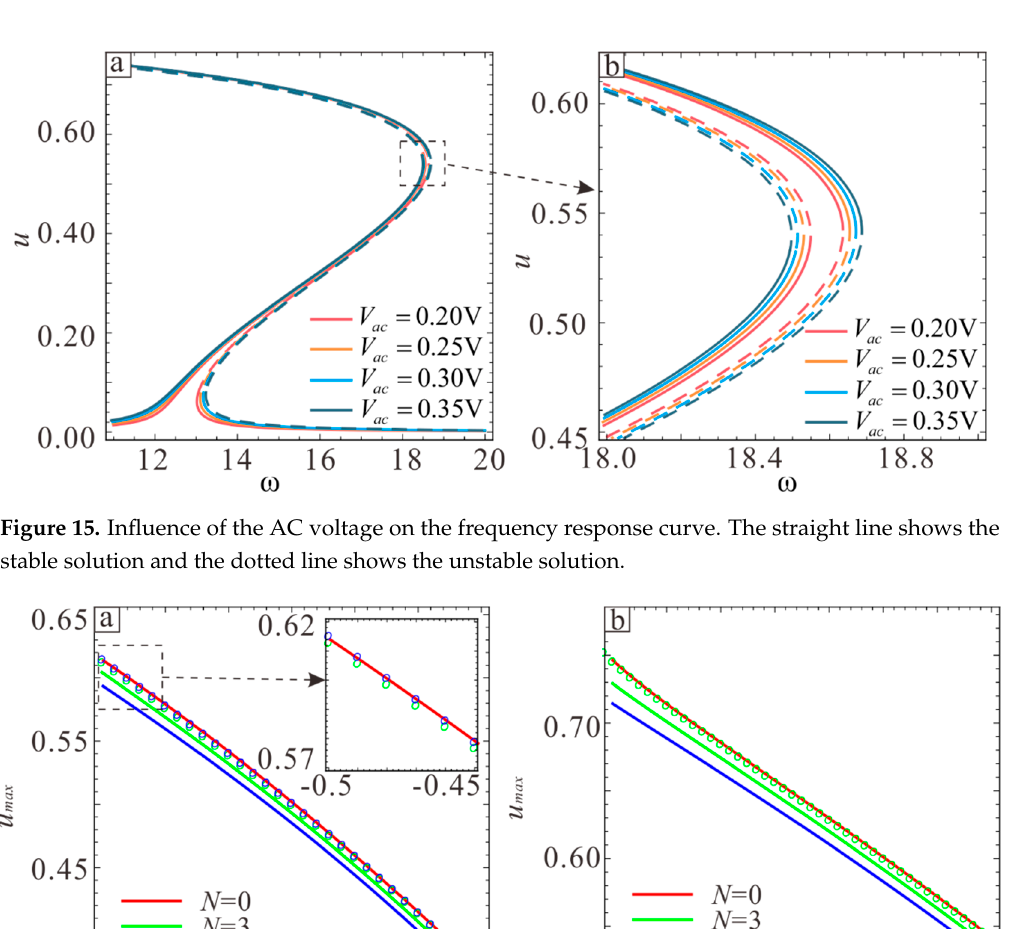
λ λ− λ λ− . ( b ) The . ( b ) The